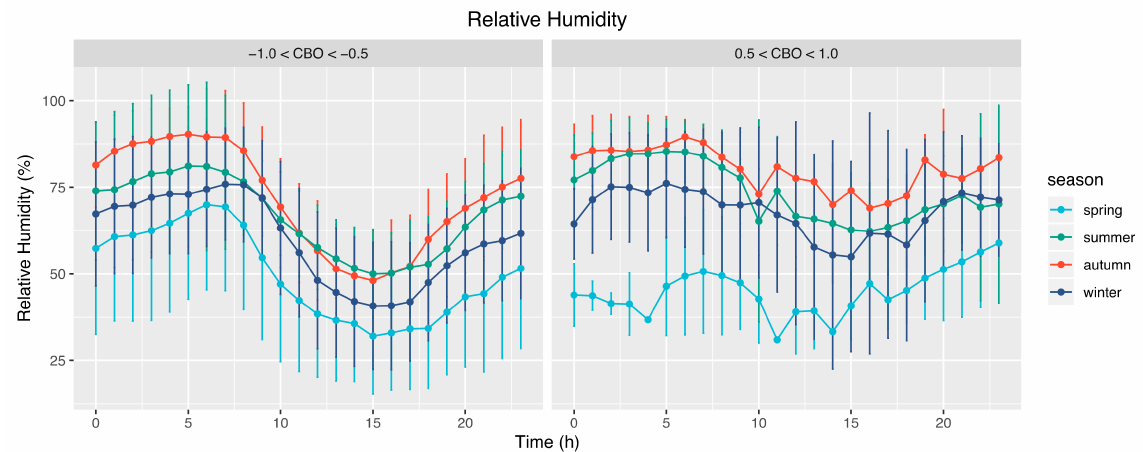
Figure 13. Diurnal variations of relative humidity in two situations: ( left ): − 1.0 < CBO < − 0.5 and ( right ): 0.5 < CBO <